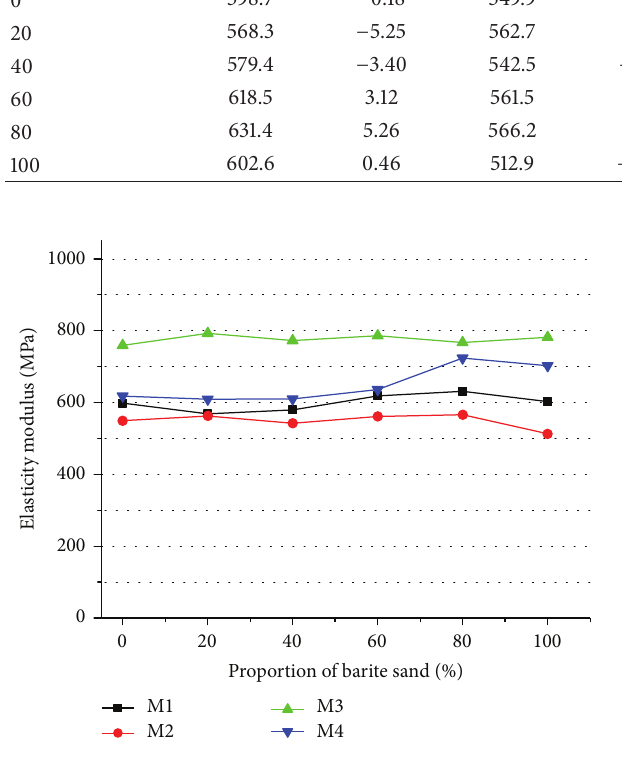
Figure 5: Elastic modulus versus the proportion of barite sand. Figure 6: Bulk density of the equivalent material versus the propor- tion of barite